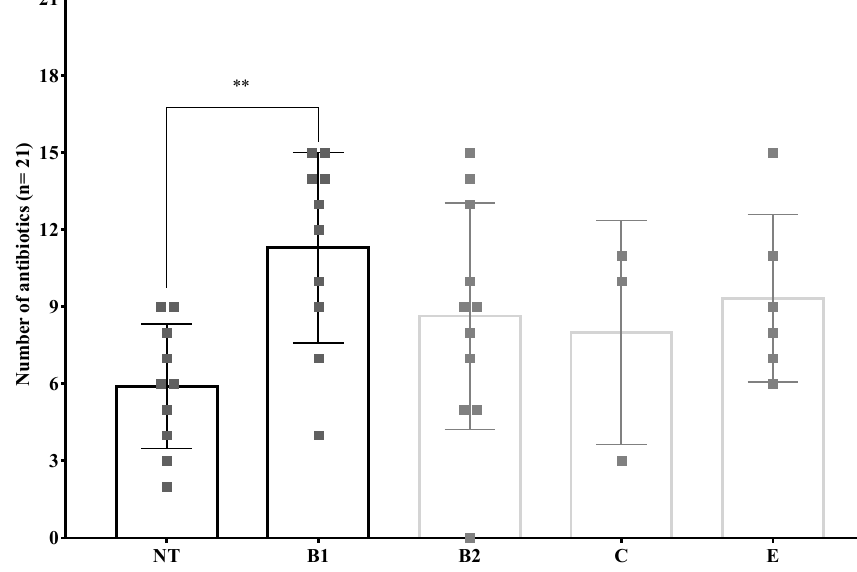
Figure 7. Mean of antibiotic resistance by phylogenetic groups. **: p = 0.01. One way ANOVA Tukey’s multiple comparisons test. Error bars show standard deviation (SD) and each gray square represent clinical isolates of specific phylogenetic group.